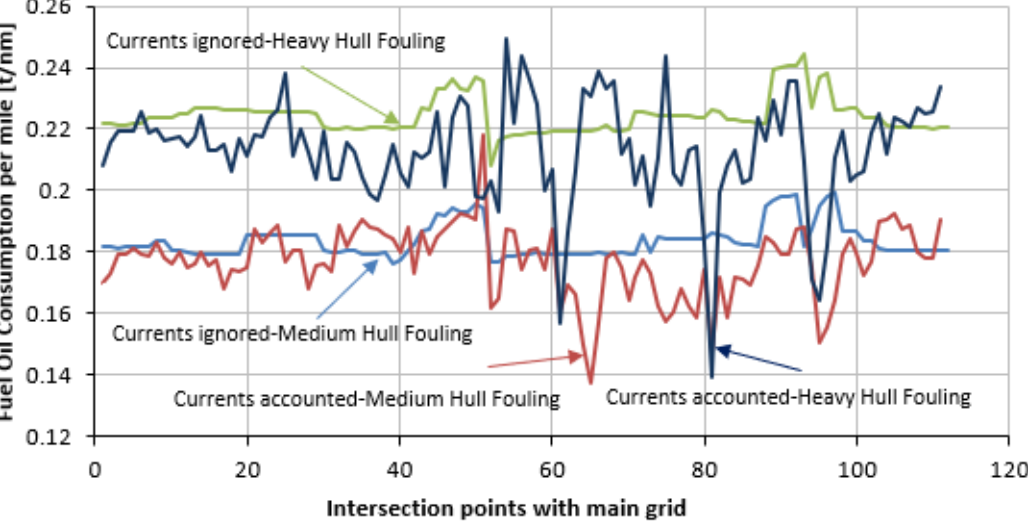
Figure 15. Fuel oil consumption per nautical mile for optimal paths with and without current effects under medium and heavy hull fouling conditions.